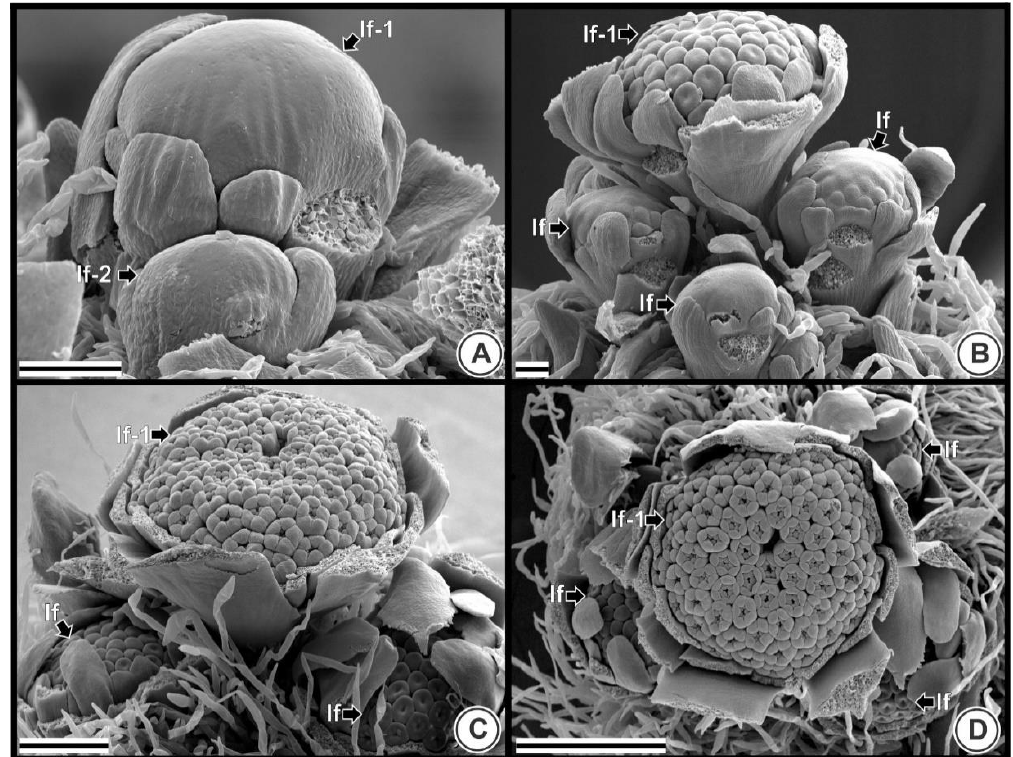
Figure 2. Inflorescences arrangement in the plant of Taraxacum kok-saghyz . Pictures were obtained by scanning electron microscopy; ( A ) Lateral view of a set of inflorescences. Inflorescence 1 in the back and a smaller inflorescence 2 in front (21 days after germination, DAG); ( B ) Lateral view of four different stages of inflorescences at 24 DAG; ( C ) Three different stages of inflorescences are observed in this picture, 30 DAG; ( D ) Top view of four inflorescences at 30 DAG. Abbreviations: DAG, days after germination; If, inflorescence. Scale bars = 150 µM.